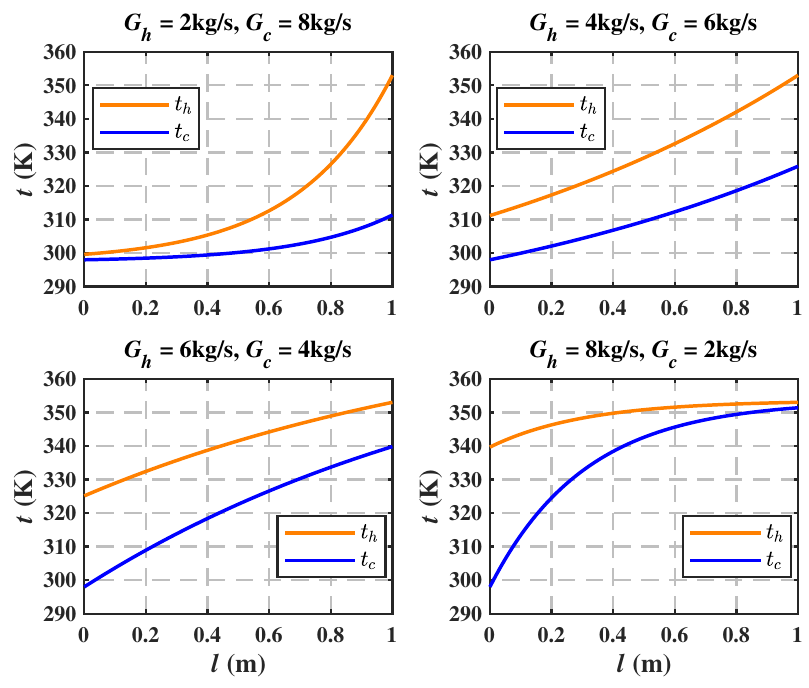
Figure 10. Temperature profiles for four pairs of mass flow